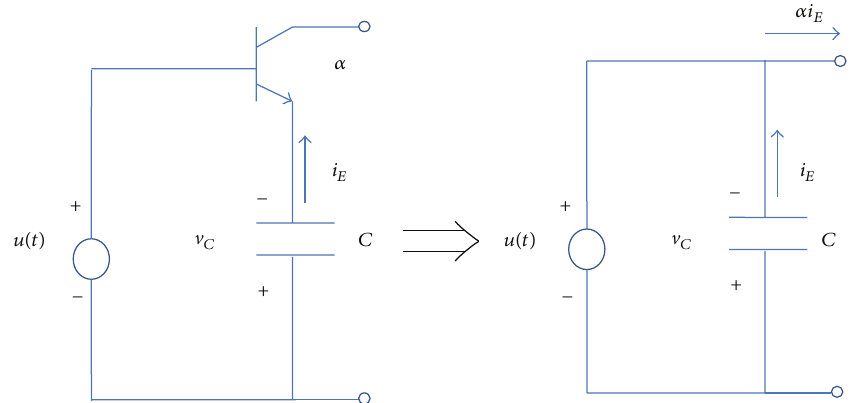
Figure 1: Descriptor circuit system with impulse